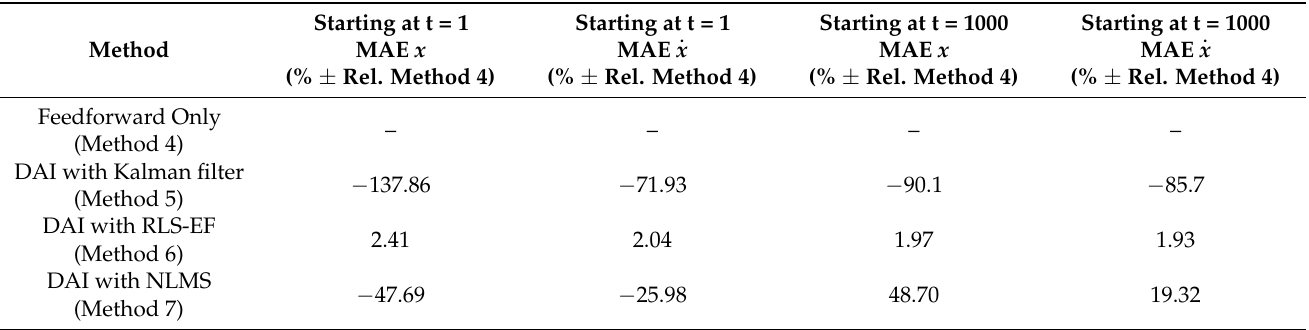
Table 3. Performance comparison. Percent mean absolute error improvement calculated between the deterministic artificial intelligence methods and method 4, feedforward only. The best result in each column is